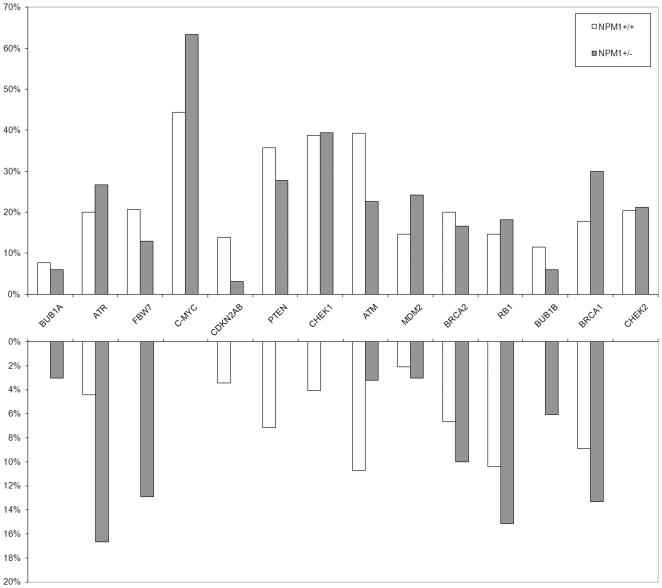
FISH investigations on clones encompassing 14 genes that are putatively involved in genomic stability.Gains (upper) and losses (lower) in NPM1+/+ patients (white columns) and NPM1+/− (grey columns).